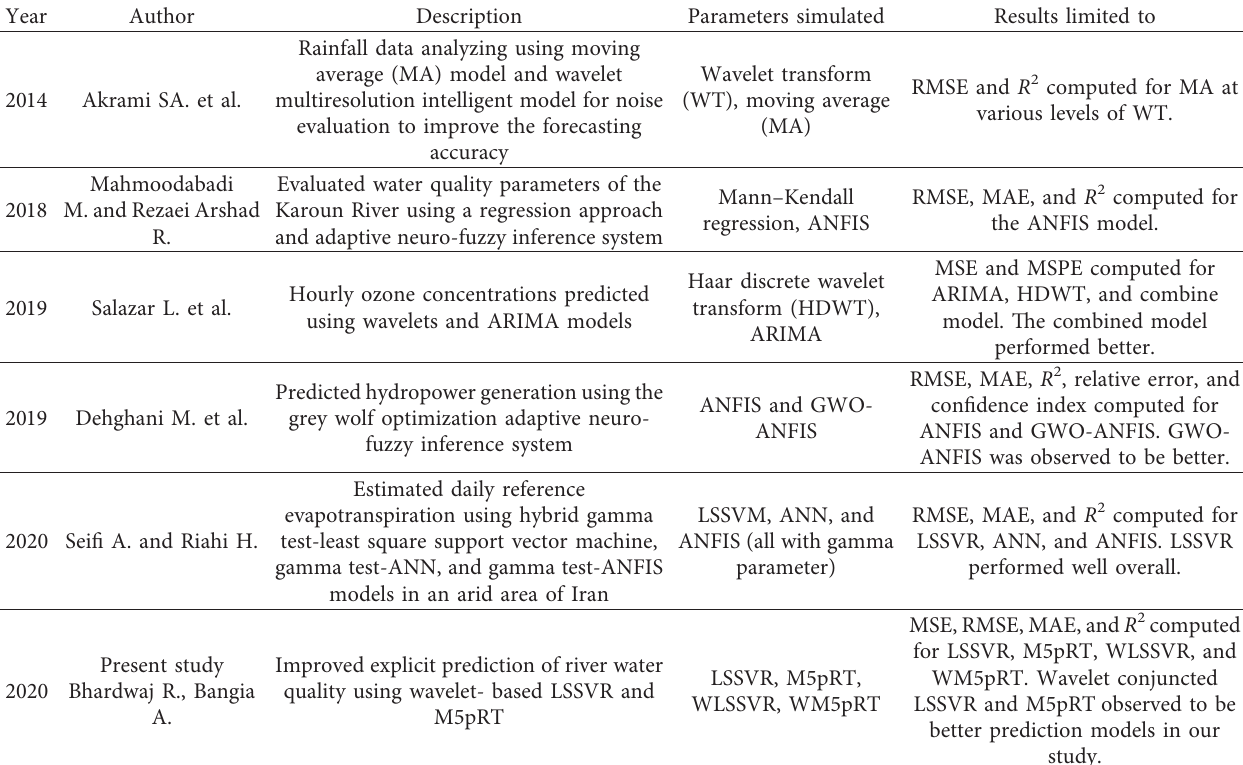
RMSE and R 2 computed for MA at (WT), moving average various levels of WT. (MA)